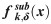
AUC scores of the fk,δsub(x) models with the variation of δ on Human dataset.